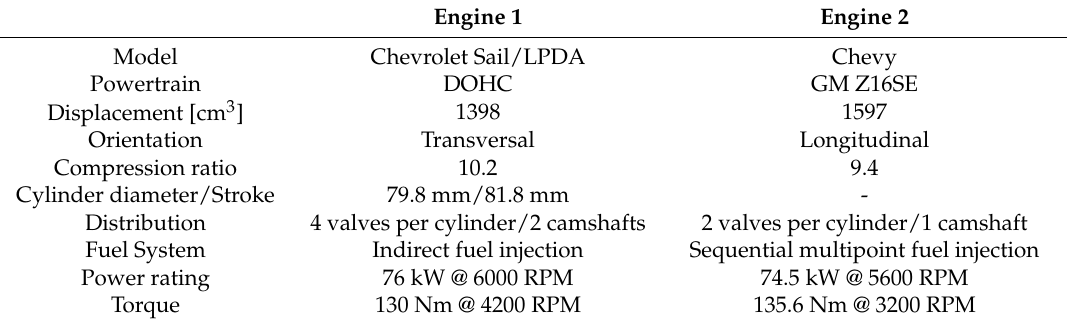
Table 3. Technical description of the engines used to evaluate changes in their performance when fueled with gasoline and E20.